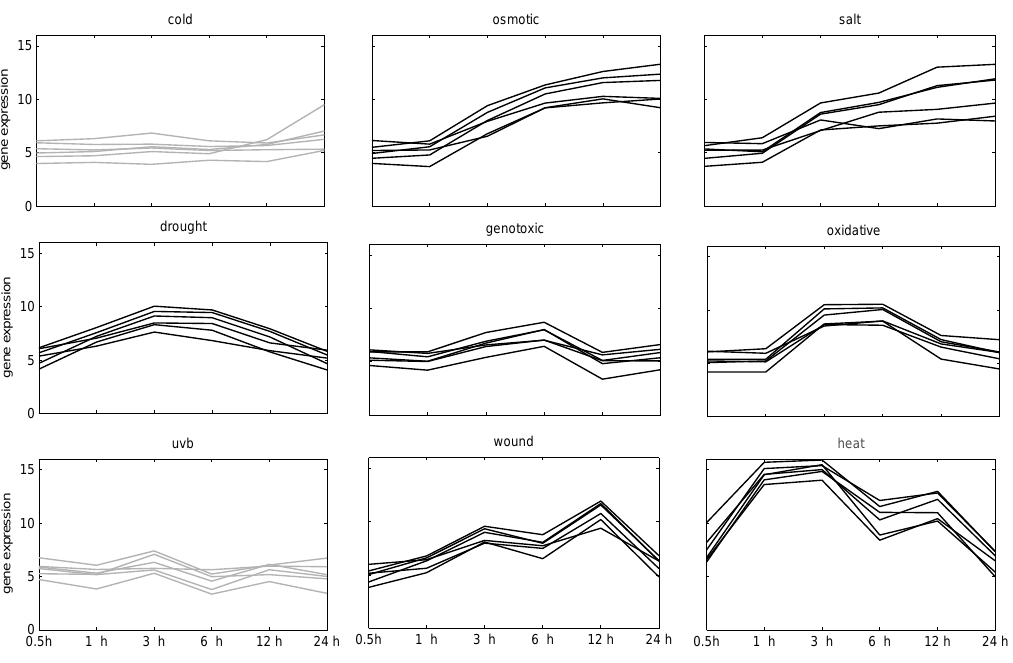
Figure 3: Module generated with heat/root as initial condition ( p -value: 1 . 87 · 10 − 5 ). The shaded conditions are not included into the cluster, whereas all conditions with a p -value below 5 % are. This leads to an IR module containing all conditions except UV-B and cold.